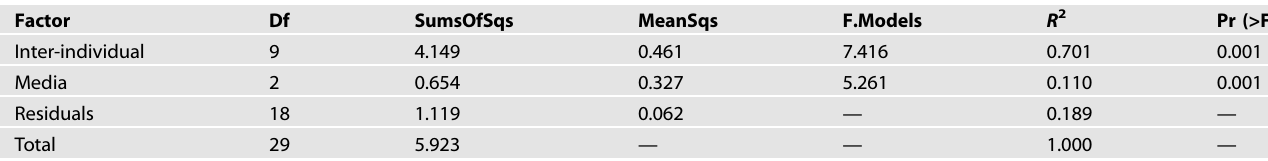
Fig. 4 The validation of optimized culture media. A Flow chart of the experiment. B Shannon index at the ASV level, D JS and Euclidean at the family level. C Bray curtis based PCoA in group of BG, GB and BGT. D Abundance of top 3 gut microbiota at the family Table 2. PERMANOVA analysis of factors (Bray_curtis).